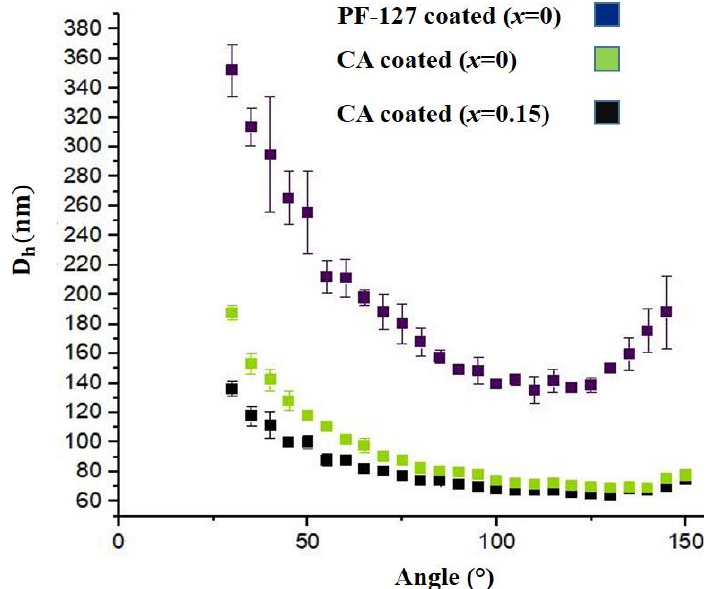
Figure 8. Average hydrodynamic diameter of nanoparticles dispersed in water for citric-acid- and pluronic F-127-coated EuMZF.